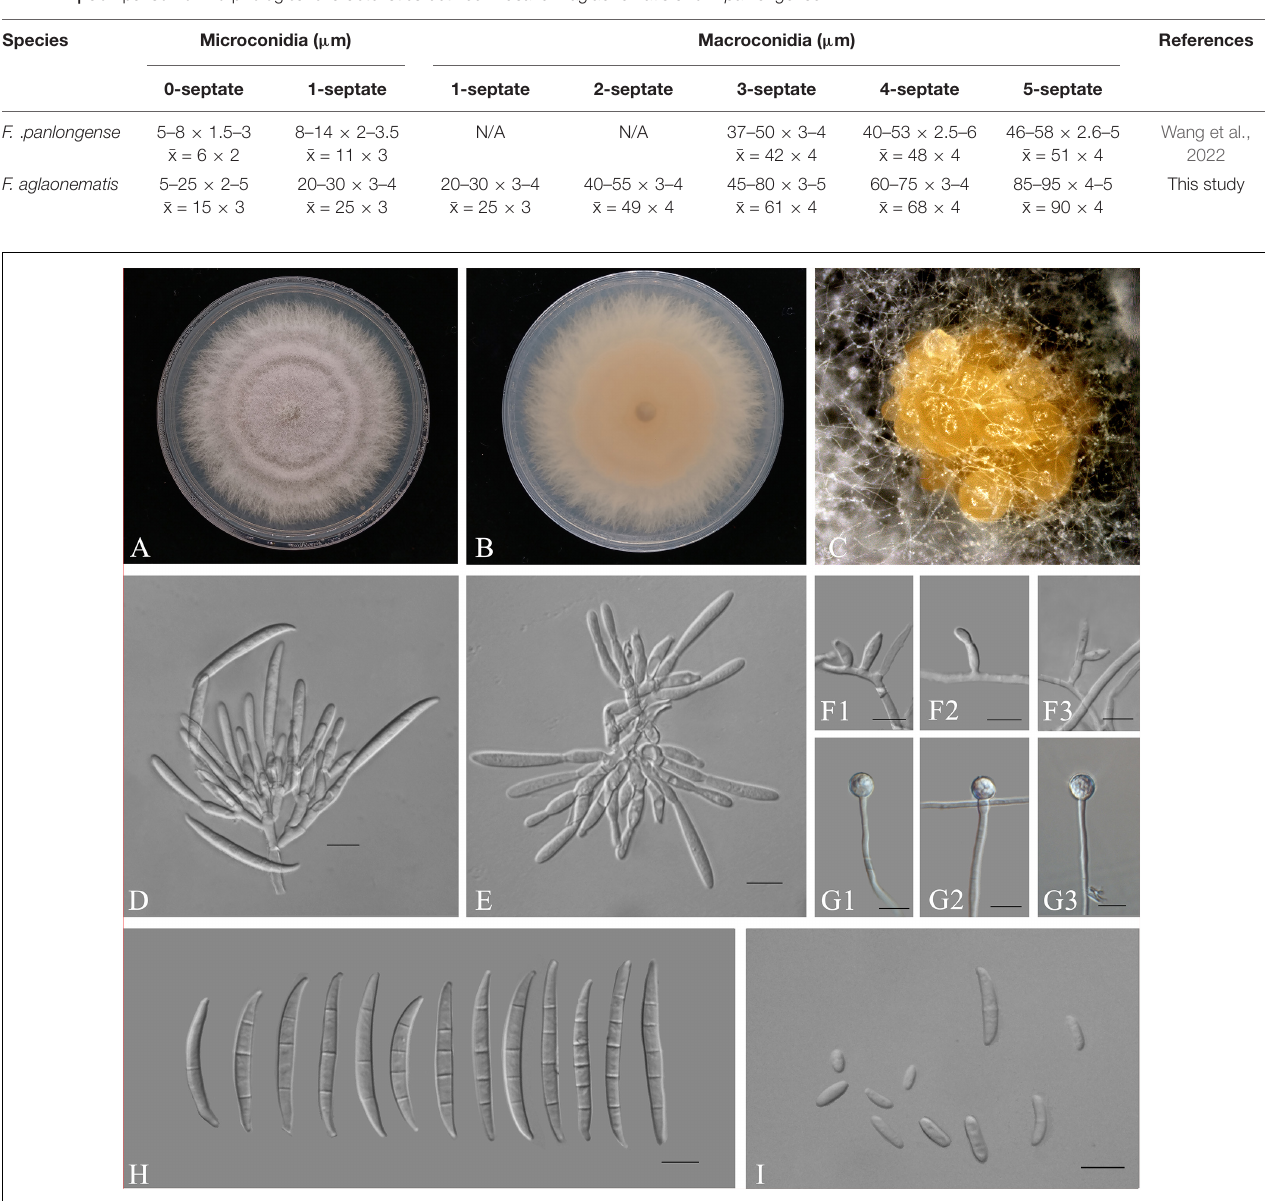
TABLE 2 | Comparison of morphological characteristics between Fusarium aglaonematis and F. panlongense. Species